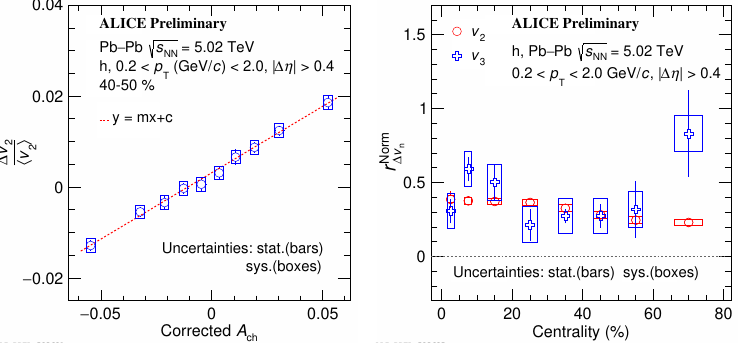
Figure 1. Left: normalized ∆ v 2 as a function of corrected A ch for the 40–50% centrality interval, with the fit function represented by a dash line. Right: slope parameter r Norm crosses), after e ffi ciency correction, as a function of